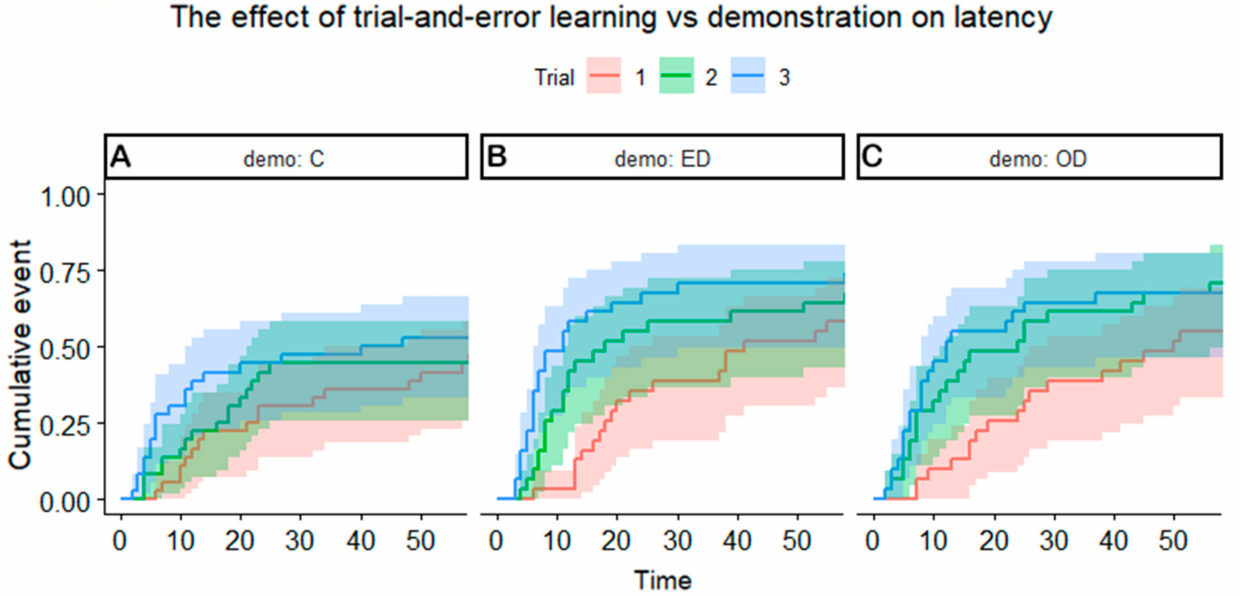
Figure 2. ( A ) Trial-and-error learning had a weak effect on learning the detour task. Dogs solved the detour faster after the demonstration both when ( B ) the experimenter demonstrated the task and ( C ) the owner demonstrated the task. There was no significant difference in the latency between the second and third trials. Abbreviations: demo: C = control; demo: ED = experimenter demonstration; demo: OD = owner demonstration.